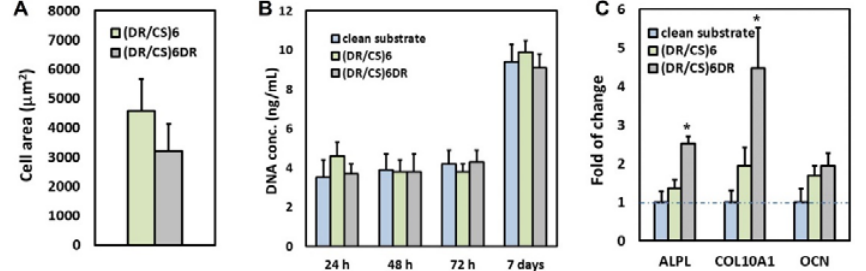
Figure 3. ( A )–Cell area 24 h after seeding. ( B )– DNA concentration of hUC-MSC proliferation eval- uated after 24, 48, 72 h, and 7 days of cell-culture on a clean substrate, (DR/CS) 6 and (DR/CS) 6 DR.